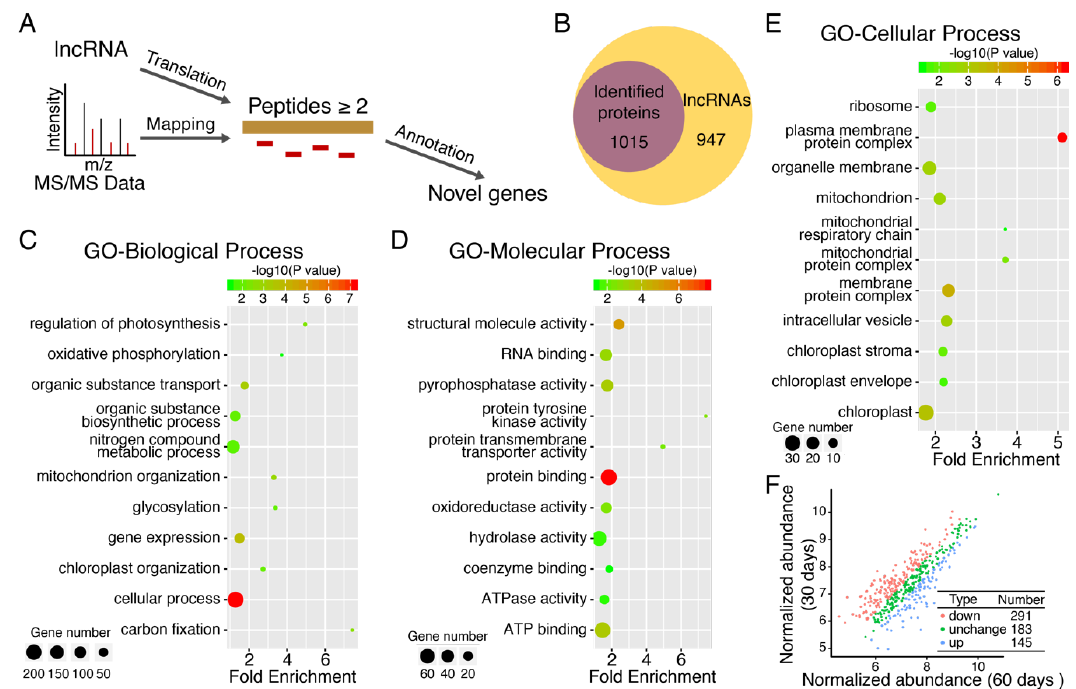
Figure 5. The re-annotation of lncRNA through mass spectrometry data. ( A ) Overview of pipeline for lncRNA re-annotation. All lncRNAs were translated into amino acid sequences. Selected Amino acid (aa) sequences (> 100 aa) were compared to mass spectrometry data and sequences with. more than 2 peptide-matches were considered to be authentic; ( B ) Venn diagram illustrating the number of lncRNA re-annotated by mass spectrometry; ( C ) The biological process for lncRNA re-annotated by mass spectrometry; ( D ) The molecular function for lncRNA re-annotated by mass spectrometry; ( E ) The cellular component for lncRNA re-annotated by mass spectrometry. Explanatory information on the functional enrichments and numbers of involved proteins in terms were all listed on the left. The cutoff of the p value is set at 0.05. Different colors (such as red, green and yellow) stand for –log10 ( p value) in the GO analysis; ( F ) The plot of differentially expressed lncRNA encoded proteins.